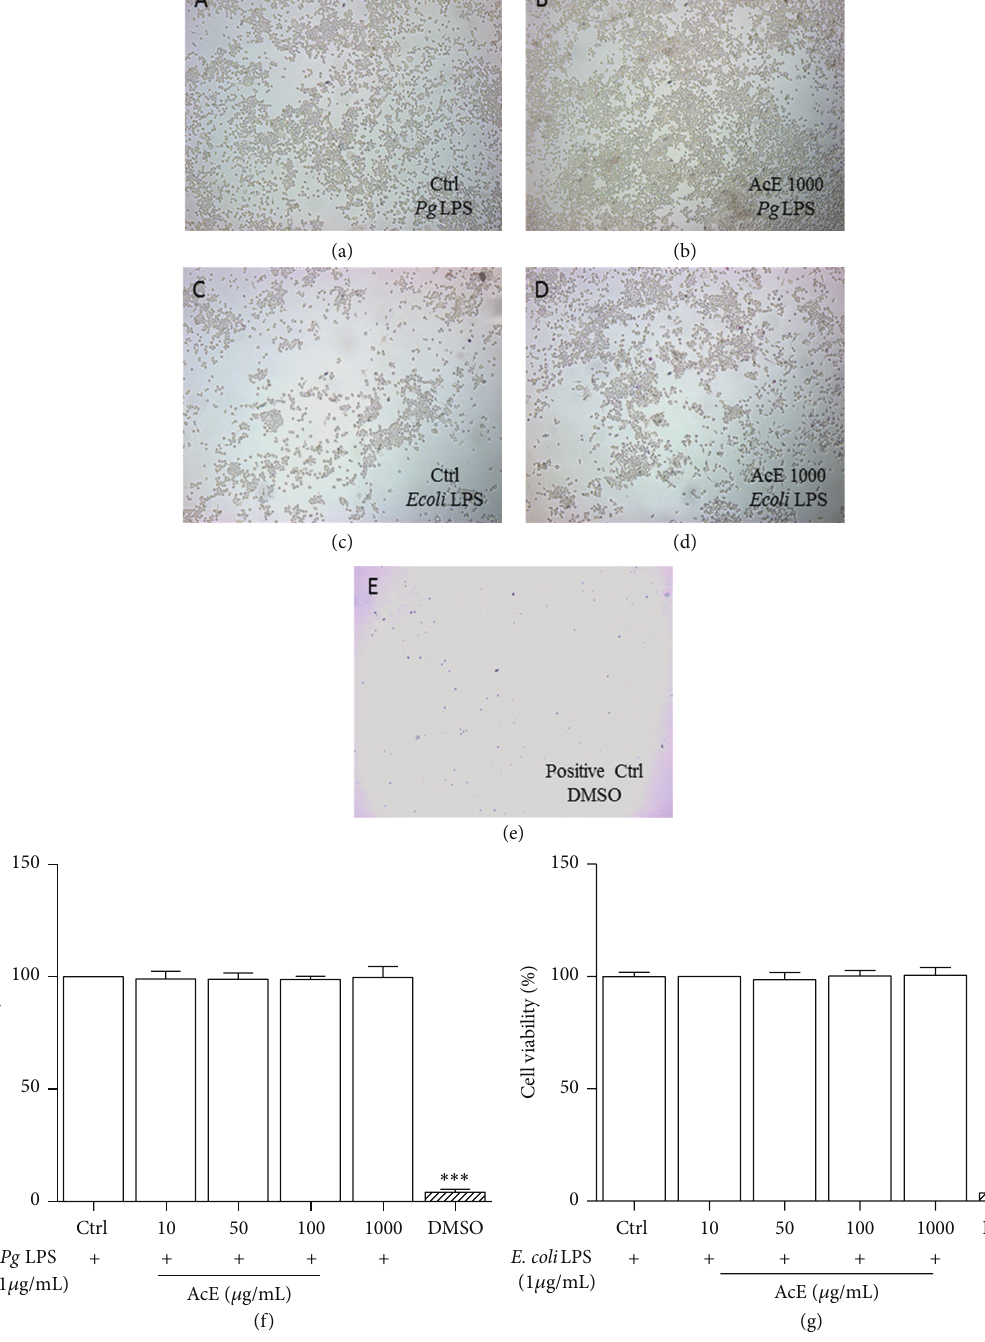
Figure 2: Effect of Allium cepa L. on cell viability on Pg LPS and E. coli LPS-induced RAW 264.7 cells. Cells were cultured in the presence of Pg LPS ((a), (b), and (f)) or E. coli LPS ((c), (d), and (g)), and AcE; untreated cells (Ctrl) were not exposed to AcE and DMSO was used for positive control (e). After 5 days of continuous exposure, cell proliferation was assessed using Alamar blue assay. Photographs shown are representative of results observed in multiple photographs taken for the following groups: Ctrl Pg LPS (a) and AcE 1000 𝜇 g/mL (b); Ctrl E. coli LPS (c) and AcE 1000 𝜇 g/mL (d). In (f) and (g) the columns represent the mean values of the results obtained of three independent experiments. There was no significance between control (Ctrl) and cells in all concentrations tested. There was significance between positive control (DMSO) and cells in all concentrations tested 𝑃 < 0.001 ∗∗∗